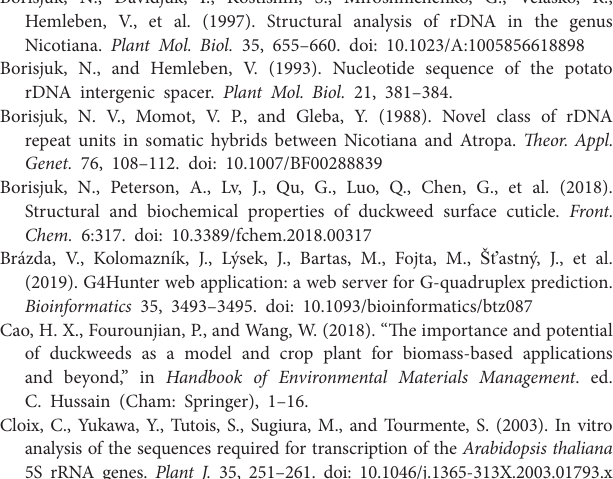
Supplementary Figure S2 | Nucleotide alignment of 30 sequences of the 5S rDNA genes cloned from Landoltia punctata . Most of the aligned sequences are compilations of the halves of neighboring gene sequences, the sequences marked with M are the 5S genes in the middle of clones containing two consecutive 5S rDNA units, as depicted in Figure 1B . The randomly varied nucleotides are highlighted by blue; the nucleotide substitution specific for the clones with short NTS (NB0014-22 and NB0014-23) at position 50, are highlighted by violet. NTS, nontranscribed spacer. Supplementary Figure S3 | Bulk alignment of Landoltia punctata 5S rDNA NTS sequences. The sequences embrace the whole intergenic region between two 5S rDNA genes. The sequence with their names followed by A and B represent the two NTS from clones containing two consecutive 5S rDNA repeats according to Figure 1B . Sequence areas which differ from the consensus are highlighted in blue. Supplementary Figure S4 | Nucleotide alignment of the Landoltia punctata 5S rDNA NTS class I sequences. 12 bp subrepeats are marked by black rectangles. Sequence areas that differ from the consensus are highlighted in blue. Supplementary Figure S5 | Nucleotide alignment of the Landoltia punctata 5S rDNA NTS class II sequences. 9 bp subrepeats are marked by black